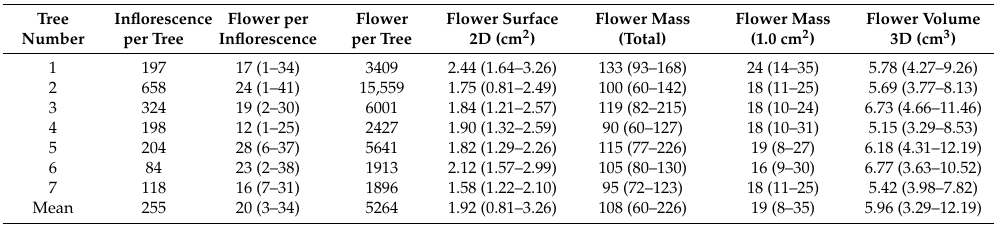
Table 3. Overview of analyzed Flower Trees and the characteristics of their flowers; counted inflorescence, and flowers per tree, flower per inflorescence, flower surface, flower weight in total, 1.0 cm 2 , and flower volume in cm 3 .